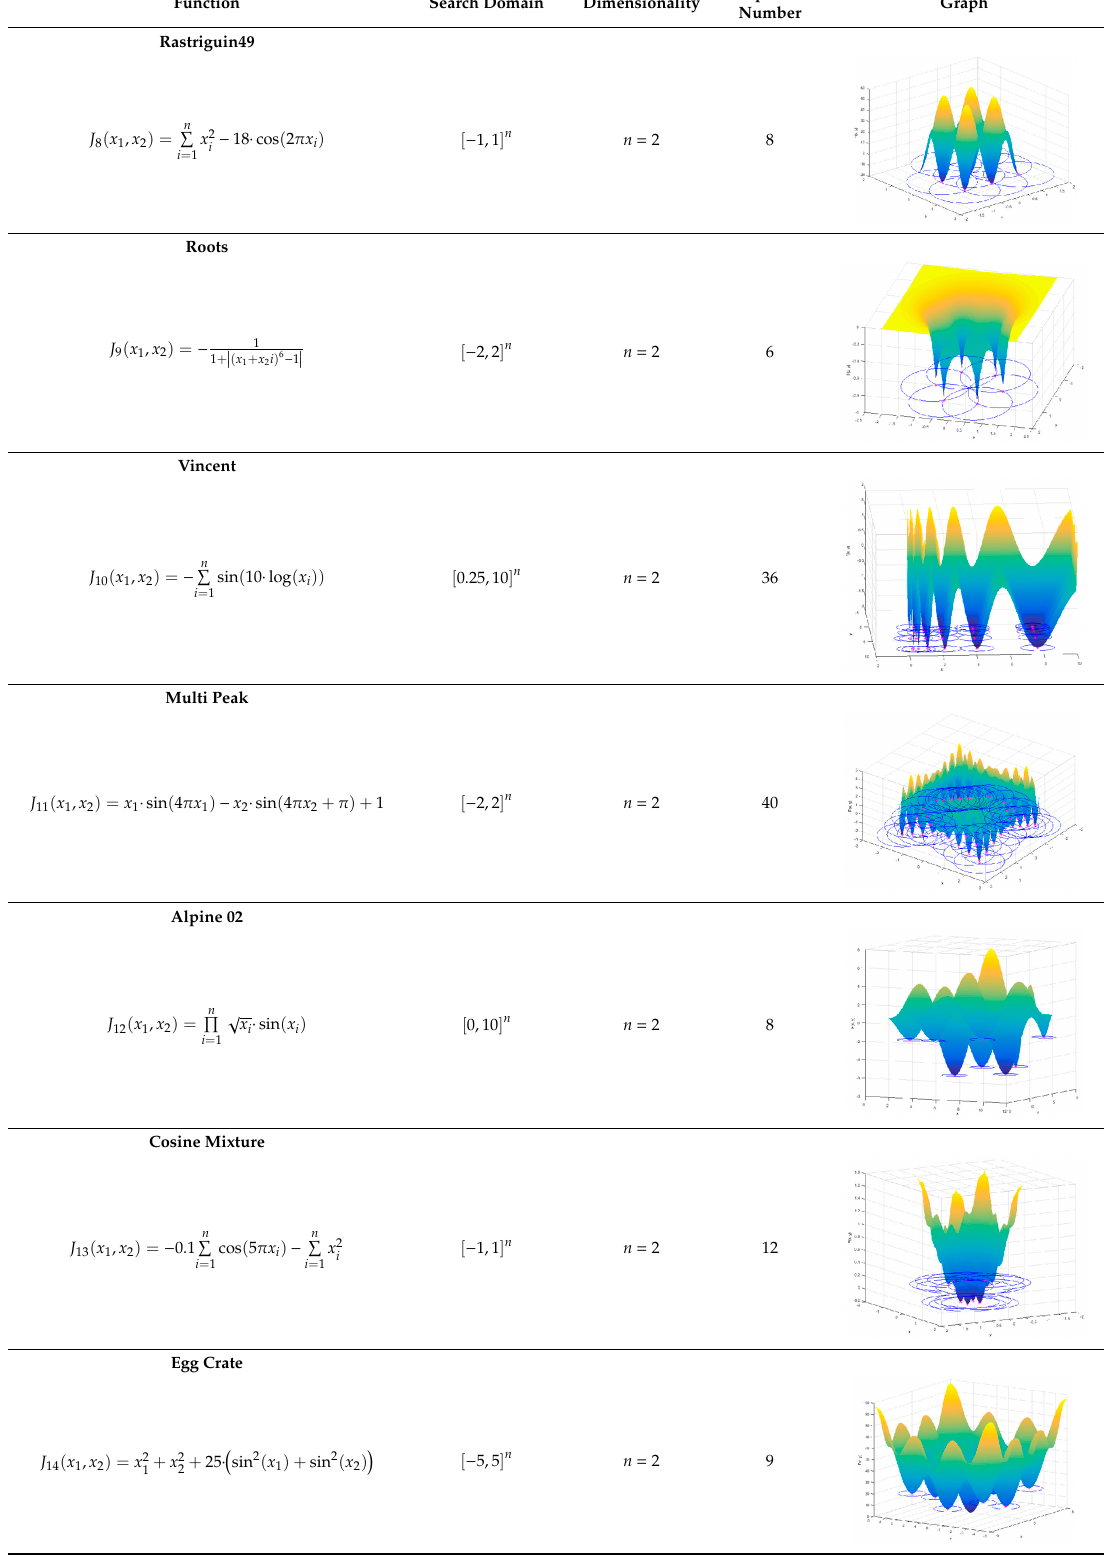
Table A2. Multimodal test functions J 8 − J 14 used in the experimental study. Function